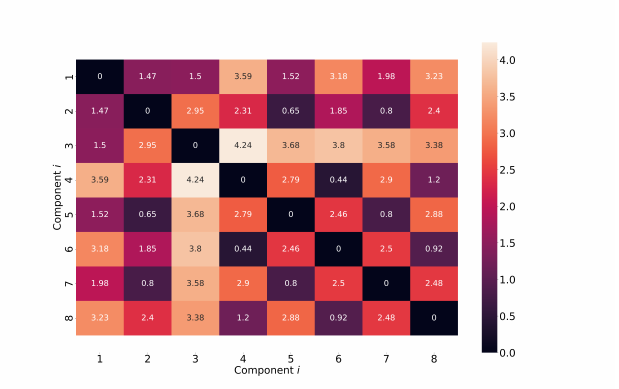
Figure 6. Health indicator for the aircraft cooling units (CUs).